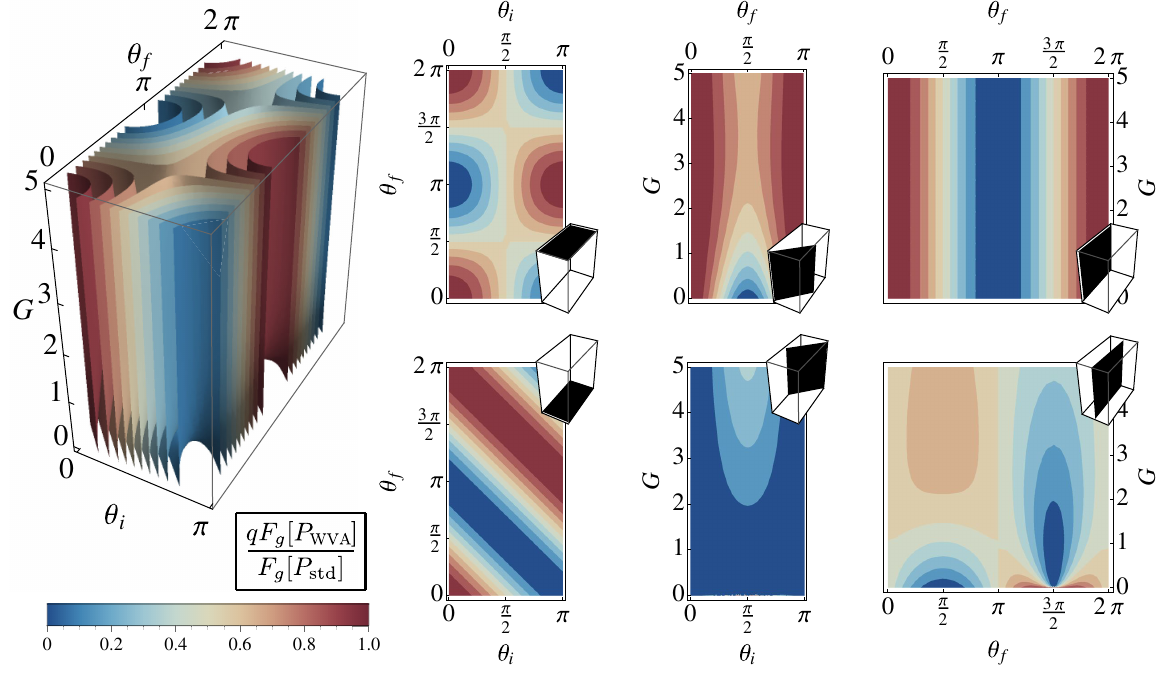
FIG. 4 The corrected Fisher information for the WVA strategy is shown in units of the standard strategy information as a contour plot in the measurement strength G and the pre- and postselection angles θ plot are taken for interesting parameter combinations. The three uppermost contour plots indicate parameter combinations for which WVA can mimic the standard technique (red regions). From left to right: In the limit of a strong measurement, G → ∞ ; when preselection and postselection are parallel, θ three lowermost contour plots indicate combinations for which the WVA technique can exhibit characteristically amplified centroids. From left to right: In the limit of a weak measurement, G → 0 ; when pre- and postselection are chosen as orthogonal, θ and when preselection is into a state unbiased with respect to the control observable, θ have colors corresponding to fractional values of qF plots, the same colors shade regions between contour lines. The symmetries of the parameter space allow us to restrict θ loss in